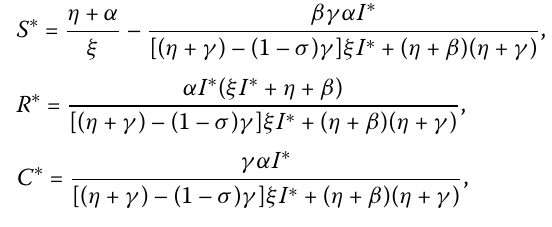
Time-delay τ > 0 is incorporated in the transmission terms to represent the incubation period of the viral infection, the time between infection and symptom onset. The current studies show that the average/median of incubation period of early confirmed cases of COVID-19 is about 5.5 days, which is similar to SARS-CoV. Presence of time-delay in the model may cause periodic solutions many times for different time-delay values τ